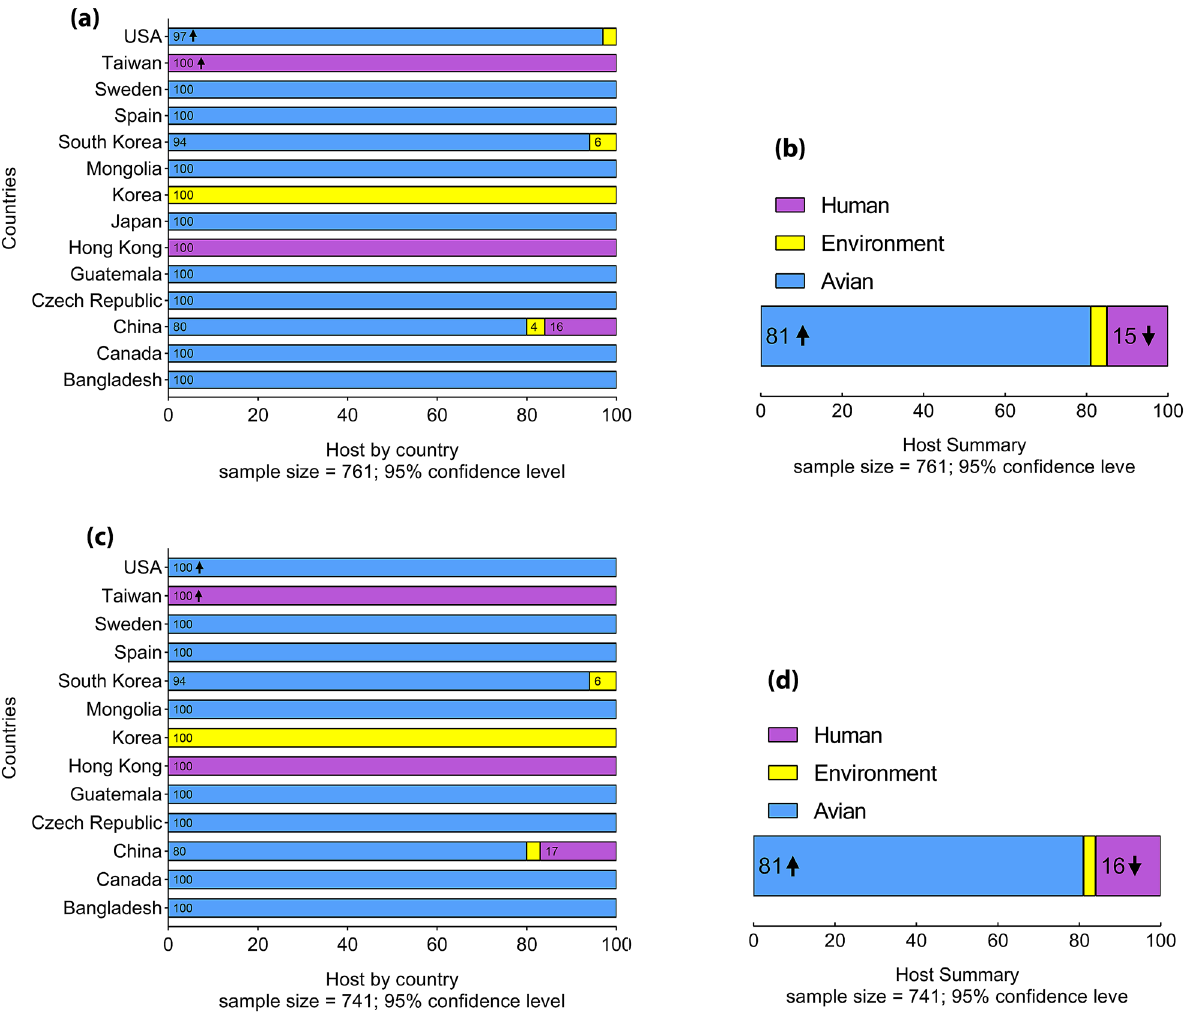
Figure 3. Chart frequency of HA and NA proteins from H7N9 Influenza. Frequency of H7N9 influenza HA protein, separately by country ( a ) and as a whole ( b ). Frequency of H7N9 influenza NA protein, separately by country ( c ) and as a whole ( d ). Human-derived, environment-derived and avian-derived H7N9 influenza (based on HA and NA protein) are shown in purple, yellow and blue, the influenza vaccine is expected to have a half-life of 10–30 h in the various prokaryotic and eukaryotic hosts. The grand average of hydropathicity (GRAVY) was computed to be − 0.834, as well as an Aliphatic index of 56.26 (Table 4). The predicted secondary structure of the final construct is presented in Supplementary Fig. S3. The possibility of disulfide bonds was investigated by the DiANNA server and it was found that the disulfide bonds have been stabilized between 17 Cys-Cys 168 , 24 Cys-Cys 630 , 29 Cys-Cys 46 , 39 Cys-Cys 359 , 47 Cys-Cys 374 , 142 Cys- Cys 280 , 205 Cys-Cys 628 , 343 Cys-Cys 417 and 355 Cys-Cys 717 amino acids. Modeling of 3D construct, refinement and validation. RoseTTAFold server was used to model H7N9vac 3D structure (Fig. 5b). Next step, the achieved H7N9vac 3D structure submitted to the GalaxyRefine server. The predicted model validation was performed by online software PROCHECK, PROSA. As shown in Fig. 5c, the Z-Score point was set to − 9.29 after refinement. The Z-Score point is used to validate the modeled protein based on the NMR or X-ray methods. The NMR method is used for the crystallography of proteins with fewer than 200 amino acids and the X-ray method for proteins with more than 200 amino acids. If the Z-Score dot in the PROSA graph is located on the (blue–blue) NMR and (pale-blue) X-ray regions, the simulation accu- racy is the highest and the simulated model has the lowest error rate with the highest confidence. Local model quality related to structure is shown in Fig. 5d. Model analysis of the predicted model after drawing the Ramachandran graph revealed that 92.4% (714/773) of all residues were in favored (98%) regions. Overall, approximately 97.8% (756/773) of all residues were in allowed (> 99.8%) regions. In the Ramachandran graph, amino acids are grouped according to the angles of phi and psi (Fig. 5e).